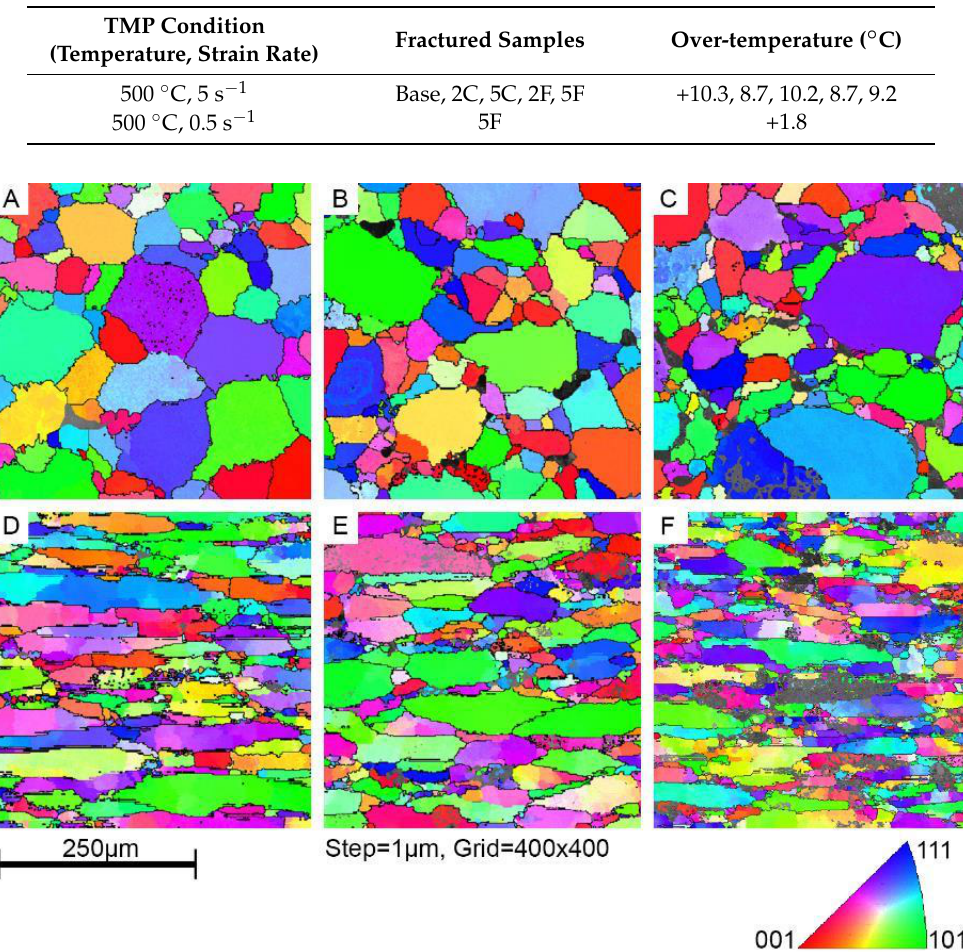
Table 3. Summary of the material chemistries and TMP conditions found to induce circumferential cracking within the forged product.